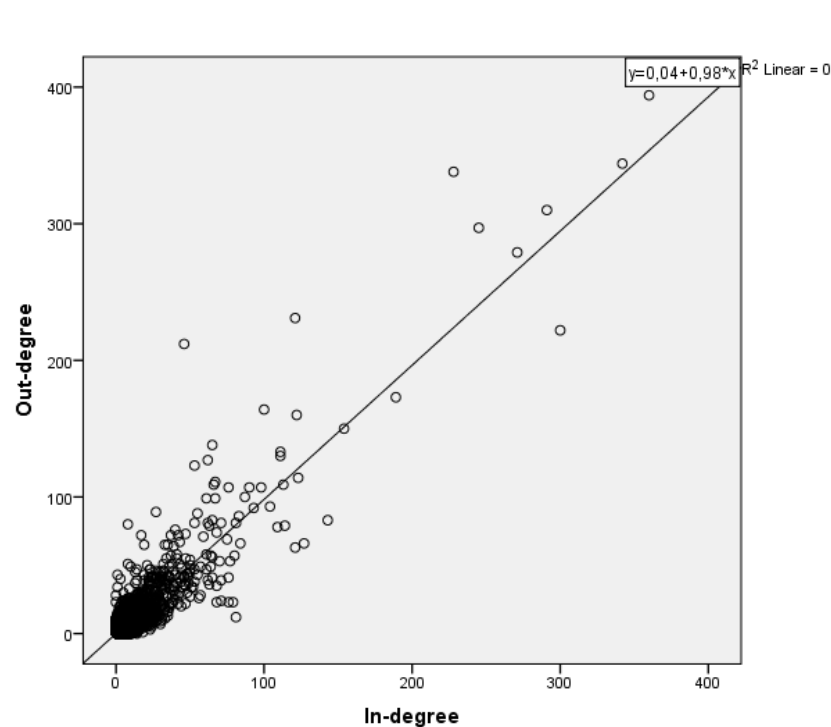
Fig. 4. Linear Regression of the In-degree and Out-degree variables. The regression is significant at the 0.01 level.